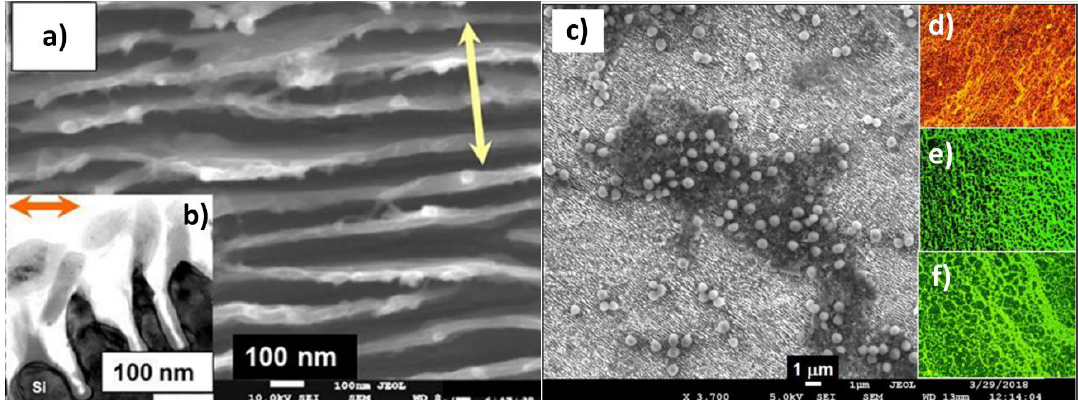
Figure 6. ( a ) High-magnification top-view SEM and ( b ) side-view cross-sectional TEM (inset) images of the surface nanoripples. ( c ) Oblique-view (20°) SEM image of the nanosharp Si pattern with the inactivated Staphylococcus aureus bacterial culture (light beads). Right insets ( d – f ): Microscopic images of stained bacteria on the nanopatterned (dead “red” bacteria, top) and smooth (live “green” bacteria, middle) Si and the control silica glass slide (live “green” bacteria, bottom) after 24 h of incubation. The frame sizes are 60 × 90 μm. (Reproduced with permission from [112]. ACS Publications, 2018).